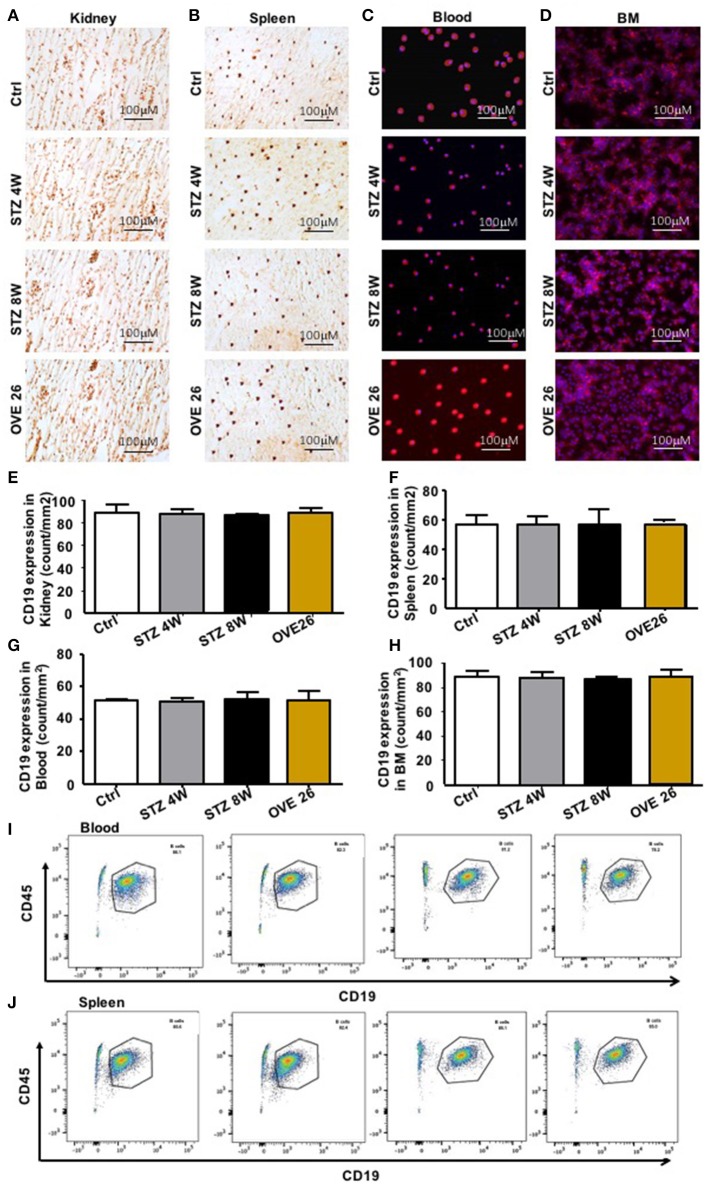
B cell expression was not affected by diabetes induction in other organs compared to heart. Immunohistochemical analysis of B cell CD19 expression and quantification in kidney (A,C), spleen (B,D), blood (E,G), and bone marrow (F,H). (I,J) Flow cytometric analysis of B cell CD19 expression and quantification in blood and spleen. Data are expressed in mean ± SEM, n = 6.